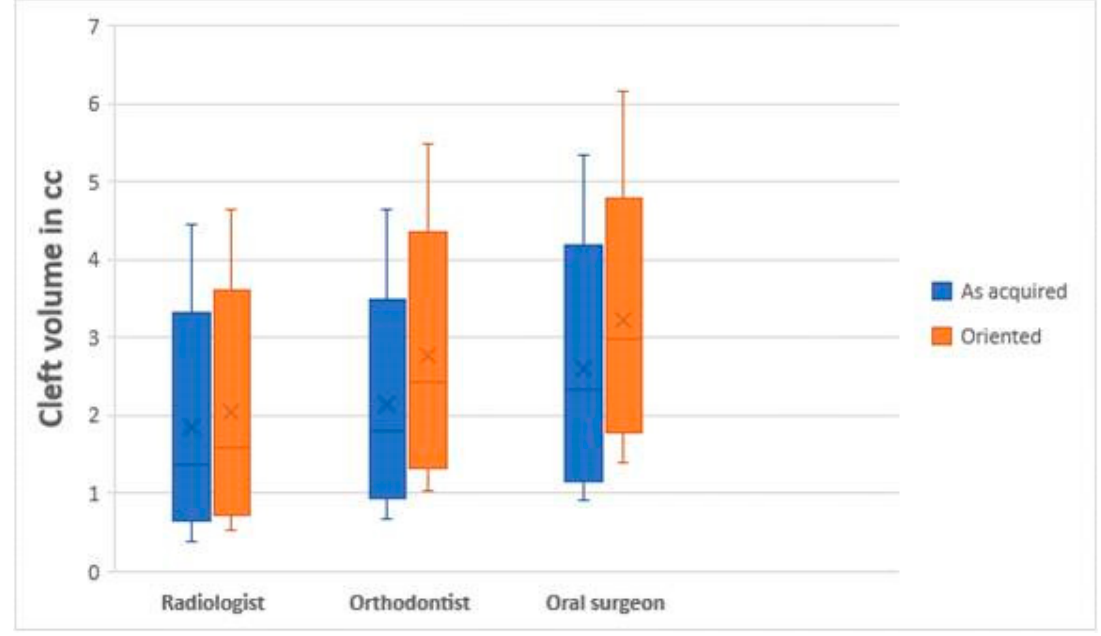
Figure 3. Box and whisker plot exhibiting observations of various specialists. The group-scatter graphs represent bone volumes for every study subject as assessed by the O1, O2 and O3. The as-acquired and oriented observations by three different observers are showcased in different group-scatter graphs (Figure 4). A collective mean for every study subject generated on the basis of observed values by the three observers is also highlighted in the graphs.